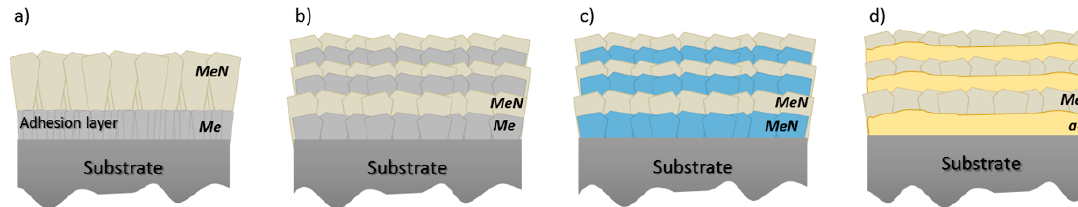
Figure 6. Schematic representation of multilayered systems used to prevent corrosion. ( a ) Metal/nitride bilayer, ( b ) metal/nitride multilayer, ( c ) dissimilar metal/nitride multilayer, and ( d ) carbon-based/nitride multilayer.